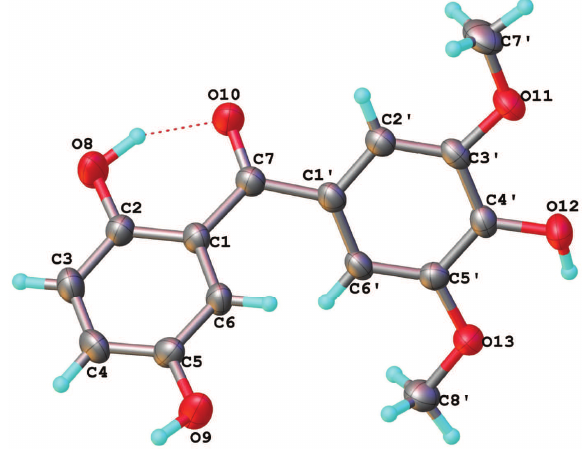
Table 1: Data collection and handling.